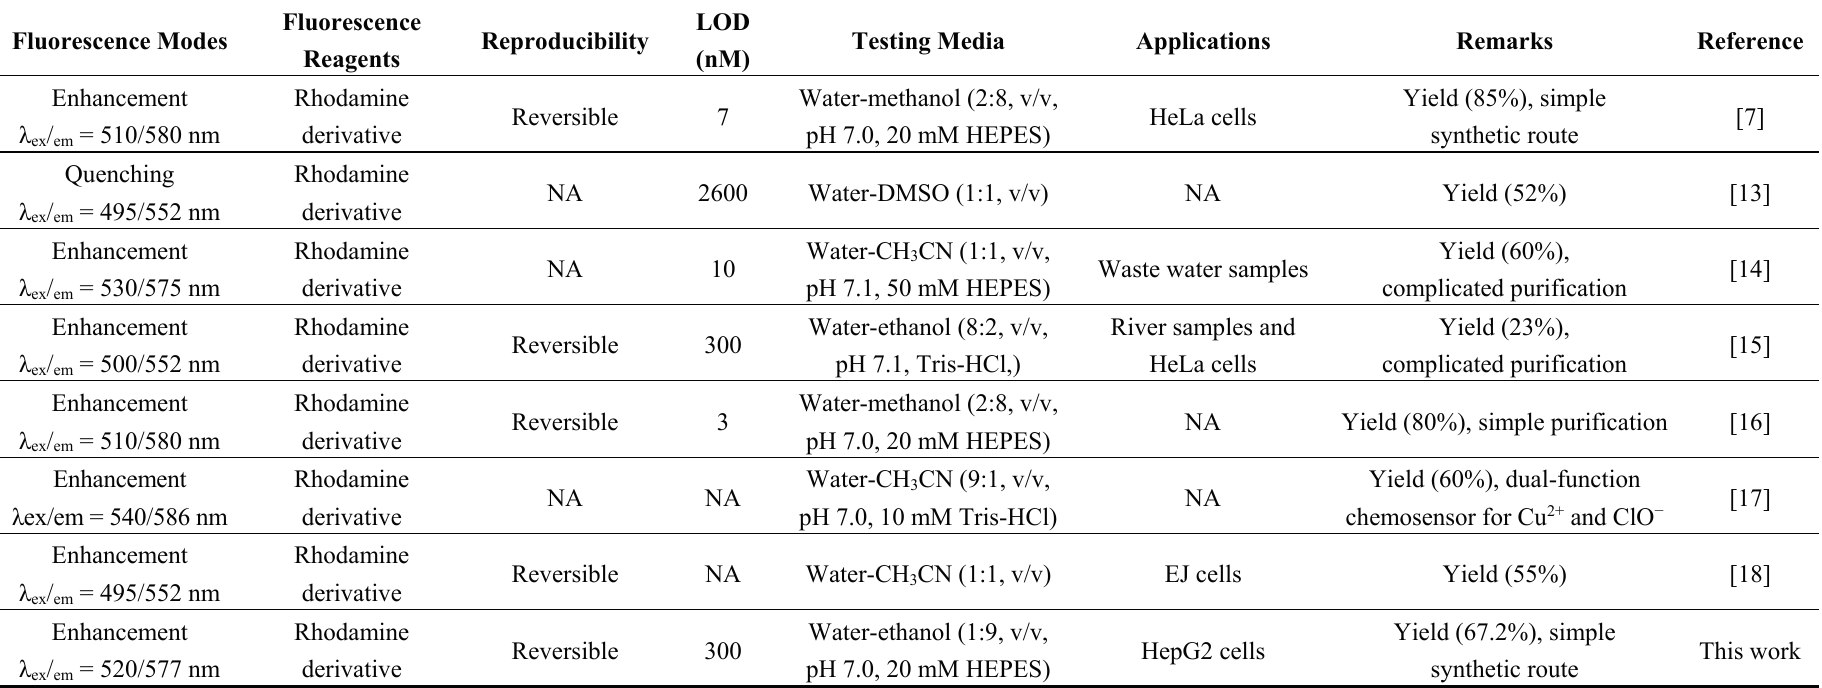
Table 1. Performance comparison of various fluorescent probes for the Cu 2+